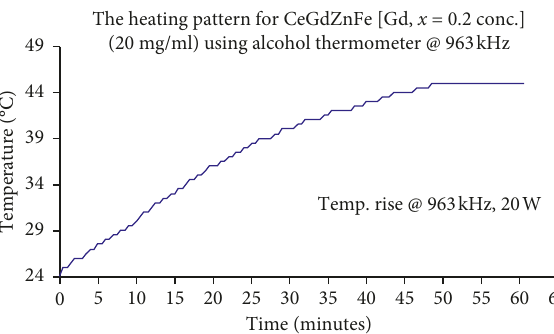
Figure 5: The heating pattern of CeGdZn-ferrite [Gd, x